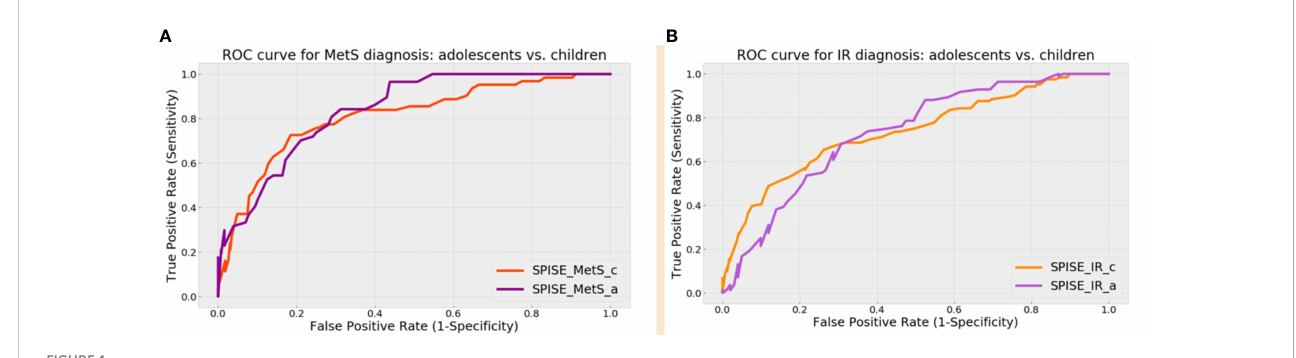
FIGURE 1 ROC Curves for MetS (A) and IR (B) screening: children vs. adolescents.